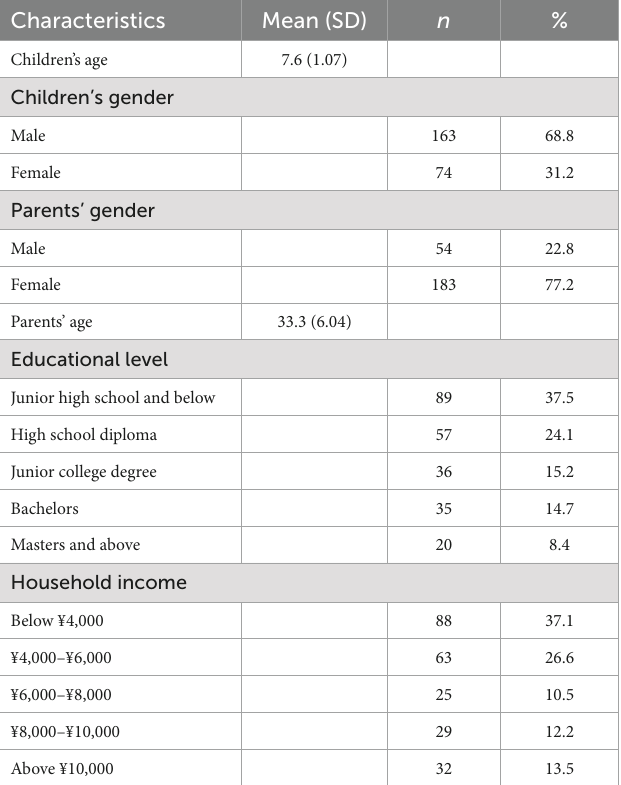
TABLE 1 The demographics of the participants.